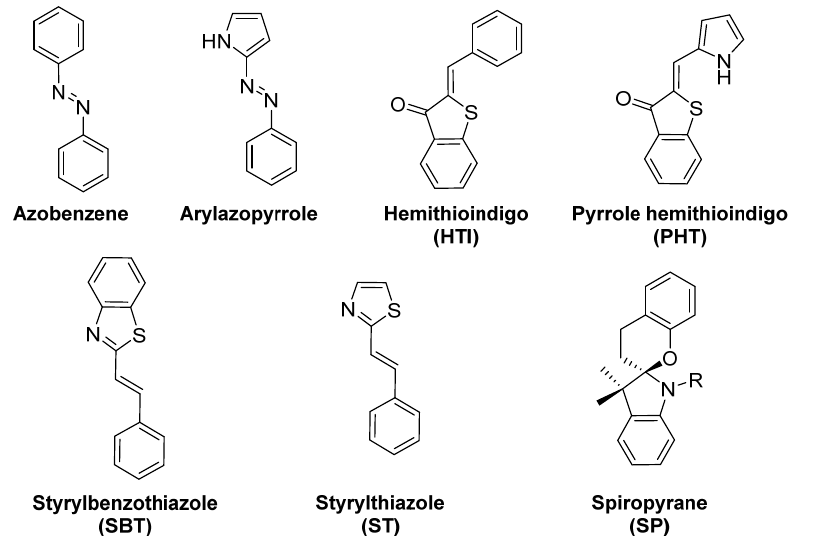
Figure 3. Overview of molecular photoswitches that have been applied to design photoswitchable microtubule ‐ targeting agents. microtubule-targeting